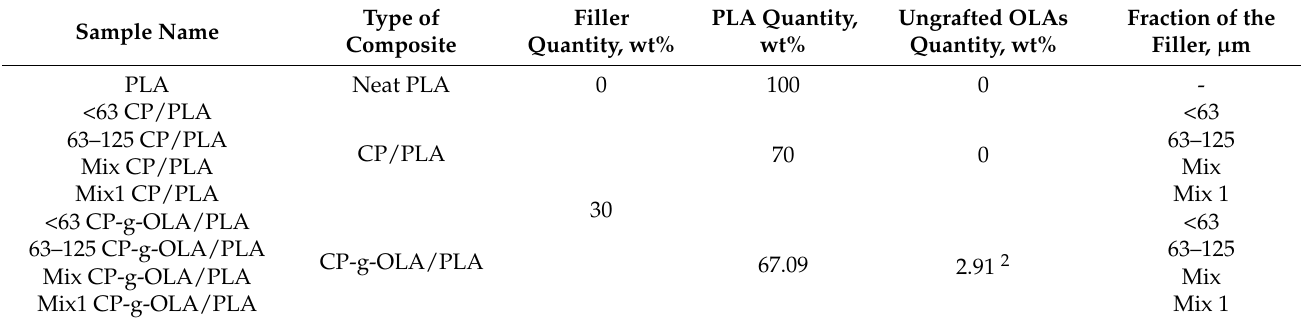
Table 4. Manufactured biocomposites